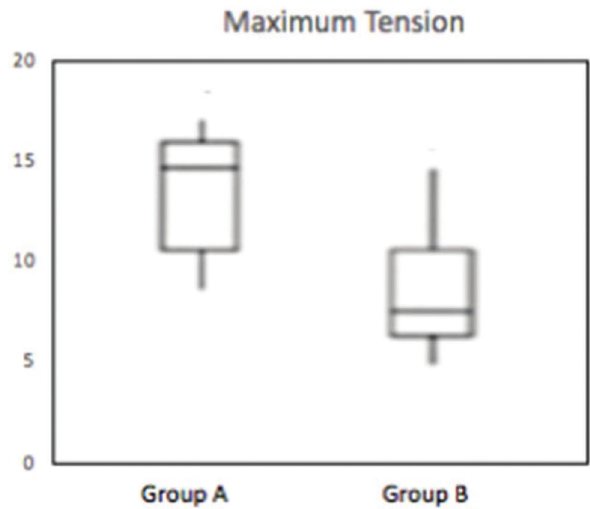
Figure 7 - Box-plot demonstrating the distribution of maximum tension (N/mm 2 ) of groups A and B ( p =0.019).